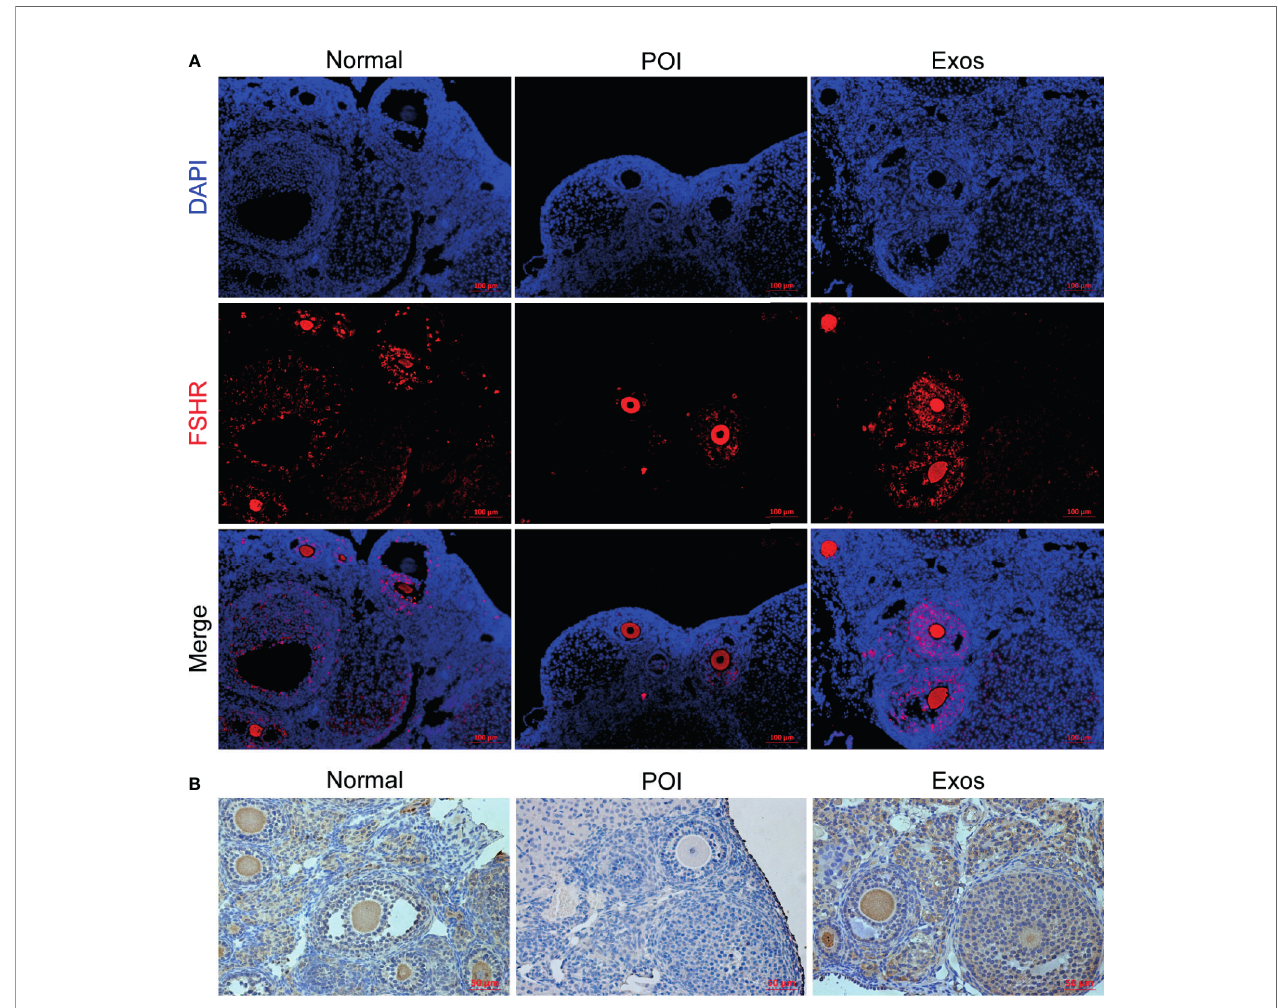
FIGURE 5 | Exosomes restored the expression levels of FSHR in GCs in vivo . (A) Expression levels of FSHR in ovaries as measured by immuno fl uorescence staining. Scale bar: 100 m m. (B) Expression levels of FSHR in ovaries as measured by immunohistochemical staining. Scale bar: 50 m